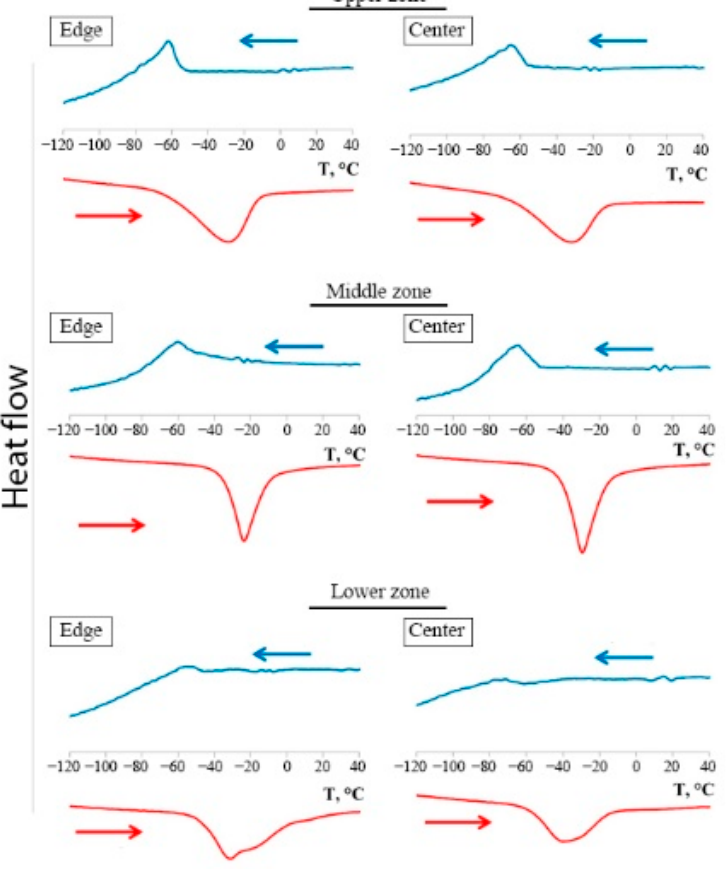
Figure 7. DSC curves for samples cut from different zones of the wall.